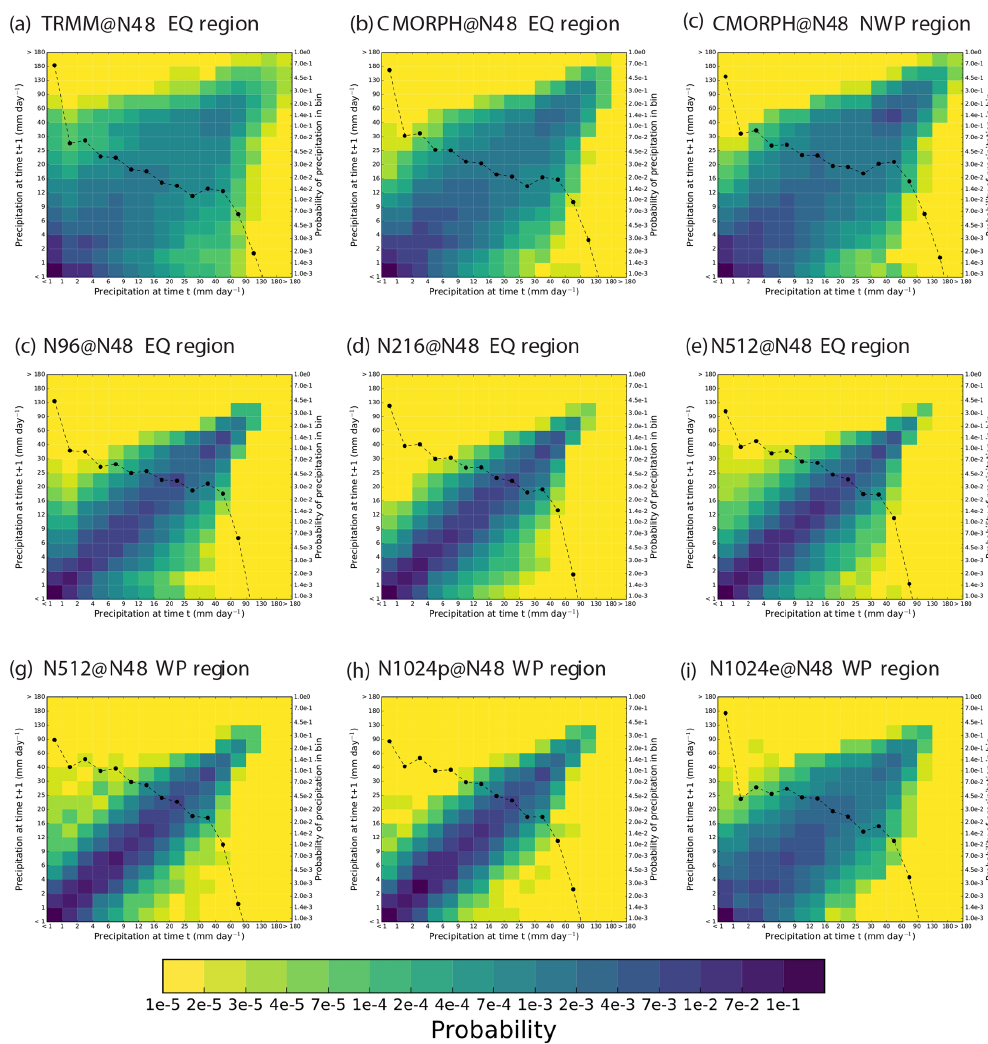
Figure 6. As in Fig. 2, but using 3h mean rain rates interpolated the 3 . 75 ◦ × 2 . 5 ◦ grid (MetUM N48 horizontal